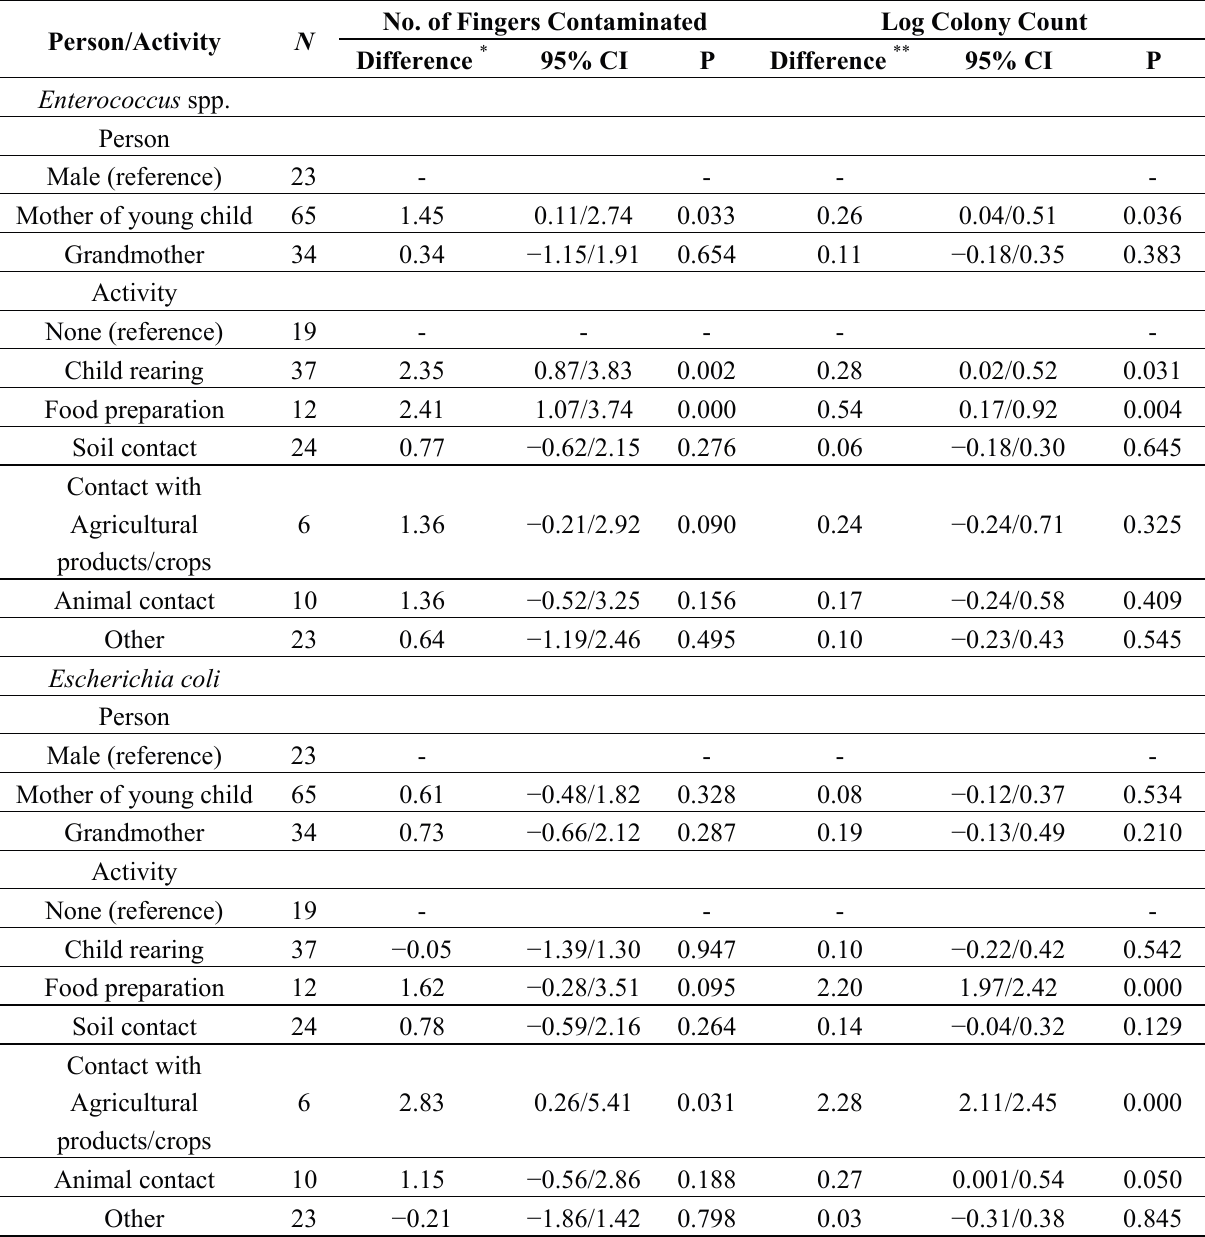
Table 2. Cross sectional study India: effect of type of person and type of activity on number of fingers contaminated and log colony count of Enterococcus and E. coli ( N =